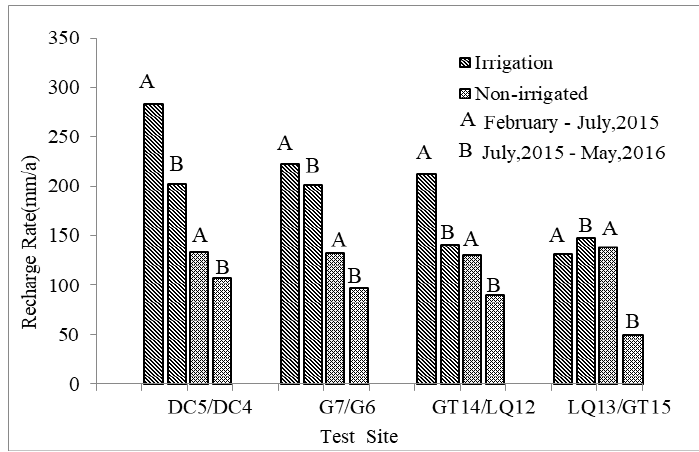
Figure 7. The recharge rate of groundwater in different periods in irrigated cropland and non-irrigated land.